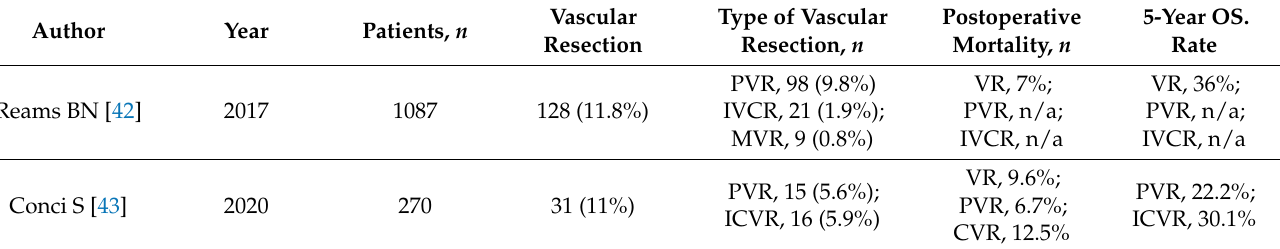
Table 1. Multi-centre studies of vascular resections in